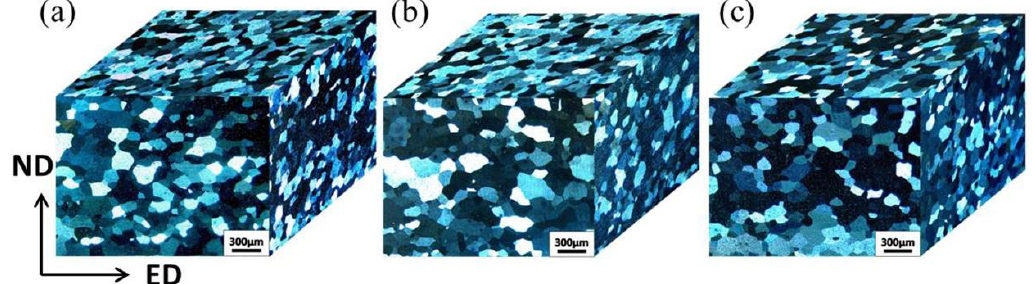
Figure 4. Three-dimensional metallographic of specimens: ( a ) A1, ( b ) A3 and ( c ) A6.